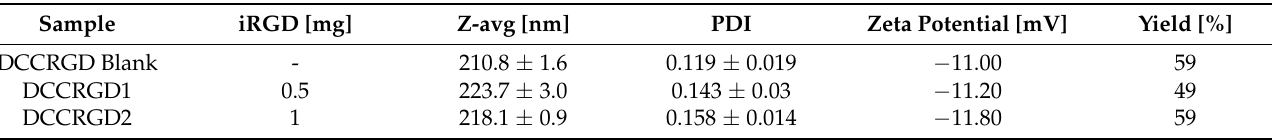
Table 5. Encapsulation of the iRGD peptide with DCC using 1:5 oil-in-water ratio, 1% ( w/v ) 12CL polymer concentration, and 1% ( w/v ) PVA